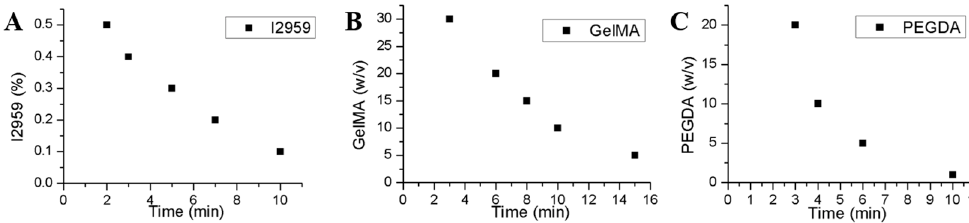
Figure 8. ( A ) The impact of I2959 concentration on gelation time, when concentration of GelMA was 10% w/v; ( B ) the impact of GelMA concentration on gelation time, when concentration of I2959 was 0.1% w/v; ( C ) the impact of PEGDA concentration on gelatin time, when concentation of I2959 was 0.1% and GelMA was 10% w / v